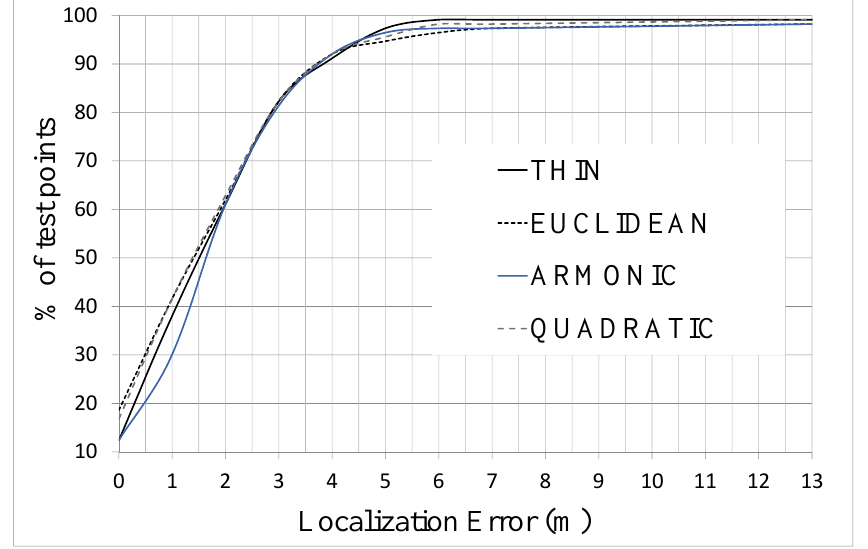
Figure 6. Percentage of test points by localization error for case A of Table 2 using different interpolation